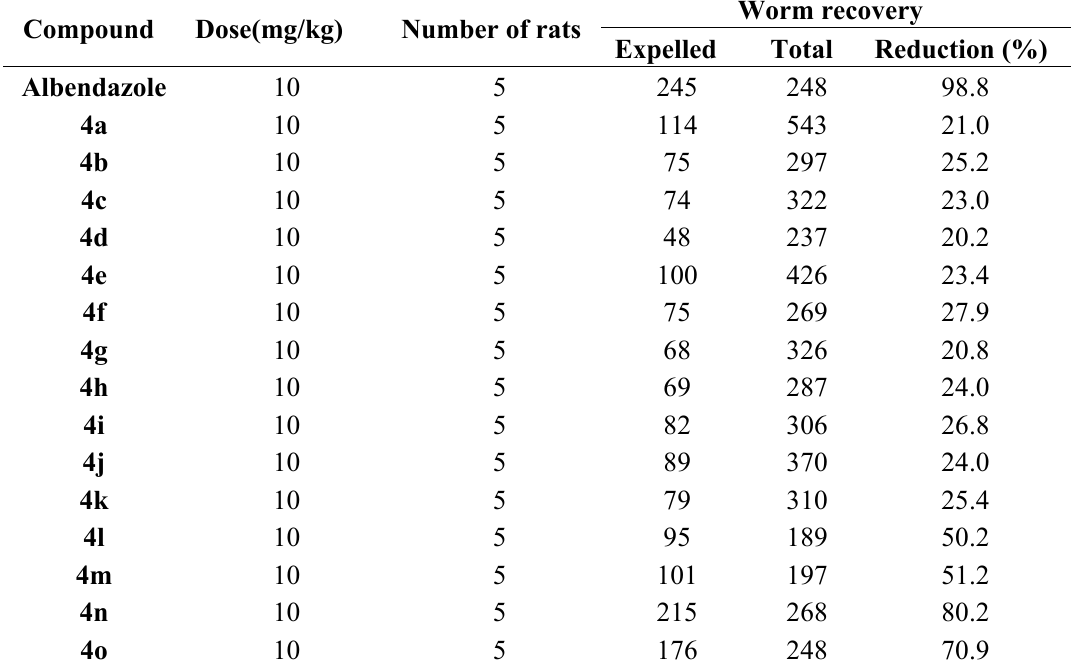
Table 1. Effect of benzo[b][1,5] naphthyridine derivatives in treatment of rats infected with NbL3 for 11 days (4a-4o)